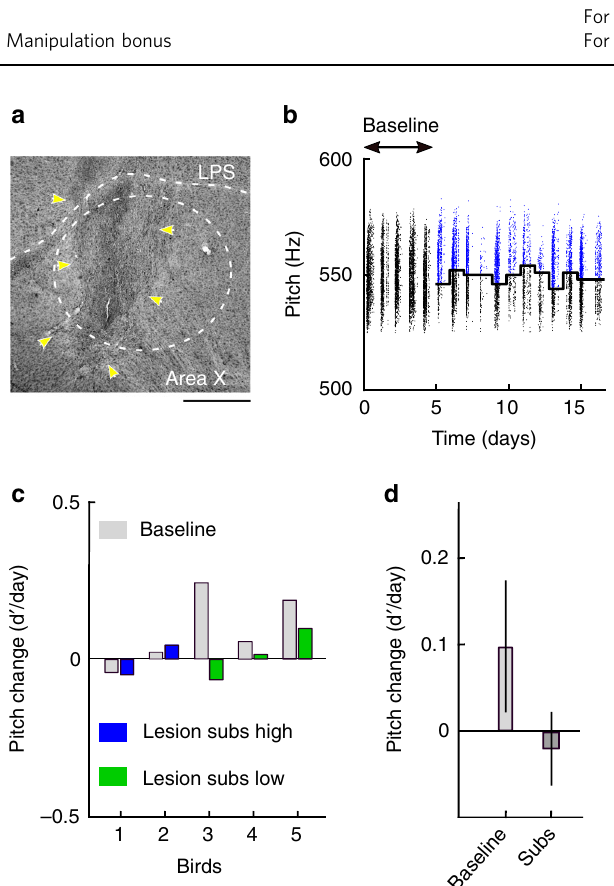
Fig. 5 A basal ganglia pathway is necessary for adaptive responses to substituted feedback. a Example sagittal brain section of a bird with lesion (yellow arrows) in Area X (dashed white ellipse). The lamina pallio- subpallialis (LPS) is indicated by the white dashed line. The scale bar on the bottom right indicates 500 µ m. Anterior is towards the left, posterior to the right. b Pitch values of all syllable renditions in an example deaf bird with bilateral lesions in Area X. There is no clear adaptive response to substitution. c The average pitch changes (d ’ /day) in deaf birds with Area X lesions during baseline (light gray), during high-pitch substitution (blue), and during low-pitch substitution (green). d The two fi xed-effect terms of a mixed linear effect model and their standard errors: the daily pitch changes (1) during baseline (left bar, p = 0.21, tstat = 1.27, df = 83, n = 5 birds), and (2) during substitution in the direction of increasing LO rate (right bar, p = 0.64, SE = 0.04, tstat = − 0.47, df = 83, n = 5 birds) are not signi fi cantly different from zero (not indicated in the fi